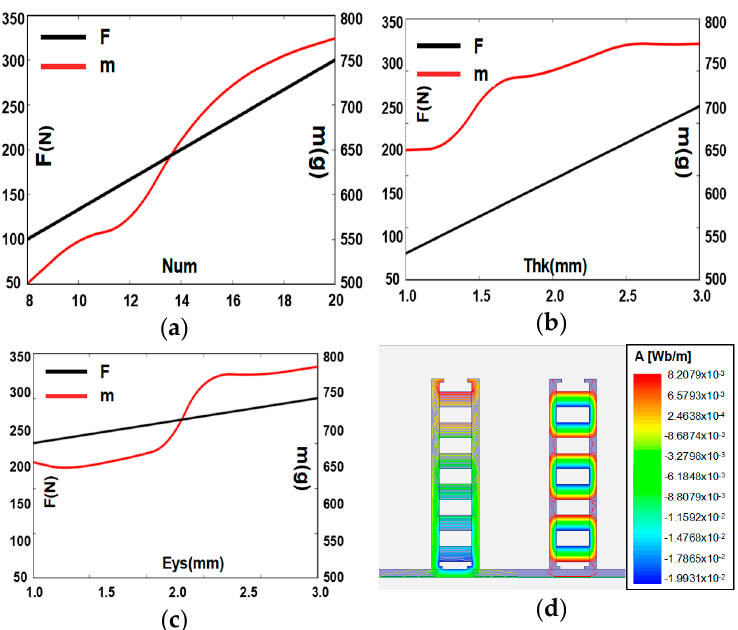
Figure 3. Influence of structural parameters on the magnetic wheel. ( a ) Number of magnets (Num); ( b ) thickness of the yoke (Thk); ( c ) thickness of the yoke hole shoulder(Eys); ( d ) arrangement.